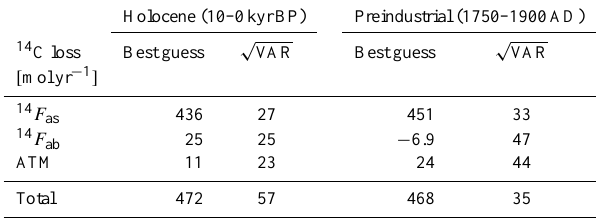
Table 2. The atmospheric radiocarbon budget (positive numbers: loss of 14 C) averaged over the last 10kyr and for preindustrial times (1750–1900AD). The statistical uncertainty becomes negli- gible due to the averaging over hundreds of datapoints and is not √ VAR (where VAR is the variance given here. Instead, we report in time) to quantify the temporal variability of the corresponding fluxes. The bulk uncertainty in the time-averaged fluxes can be es- timated by the uncertainty in the corresponding radiocarbon reser- voirs and is of the order of 15% (1 σ ), except for the atmospheric component which is tightly constrained by